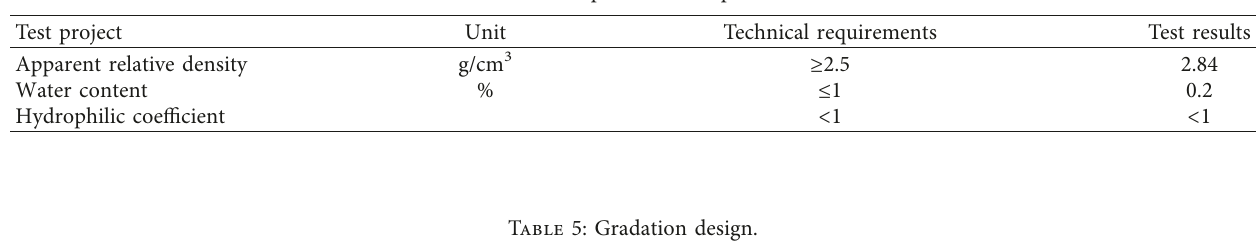
Table 4: Properties of ore powder.